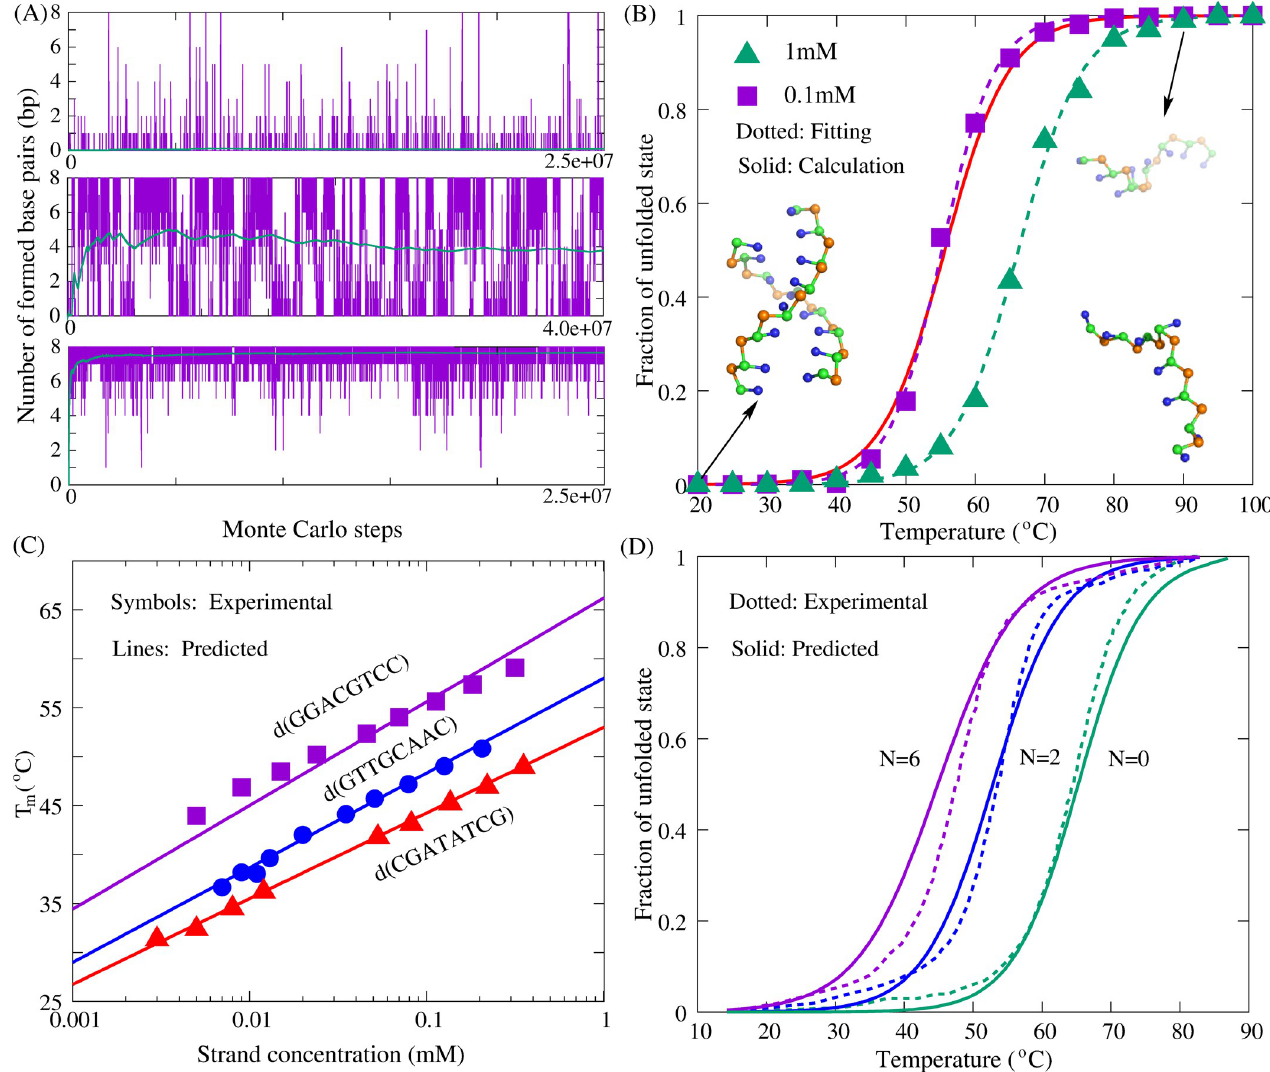
Fig 4. The stability predictions for dsDNAs in the present model. (A) The time-evolution of the number of base-pairs for a dsDNA (sequence: (GGACGTCC) 2 ; strand concentration: 1mM) at different temperatures (90˚C, 65˚C, 40˚C from top to bottom, respectively) in 1M NaCl solution. (B) The fractions of unfolded state f as functions of temperature for the dsDNA in (A). Green triangle: predictions at high strand concentration (1mM). Purple square: predictions at experimental strand concentration (0.1mM). Two dotted lines are the fitted melting curves to the corresponding predicted data. The solid line is calculated through Eq 7. Ball-stick: the typical 3D structures predicted at low and high temperatures shown with PyMol (http://www.pymol.org). (C) The melting temperatures ( T m ’s) as functions of strand concentration for three dsDNAs: purple, (GGACGTCC) 2 , blue, (GTTGCAAC) 2 , and red, (CGATATCG) 2 at 1M [Na + ]. Symbols: experimental results [71]. Lines: predictions from the present model. (D) The predicted (solid lines) and experimental (dotted lines) melting curves [89] for the dsDNA harboring symmetric internal loops with sequences of CTCGTC(T) N CAGTGC/GCACTG(T) N GACGAG in 1M NaCl solution. Green: N = 0, i.e., the double helix without internal loop. Blue: N = 2. Purple: N = 6.